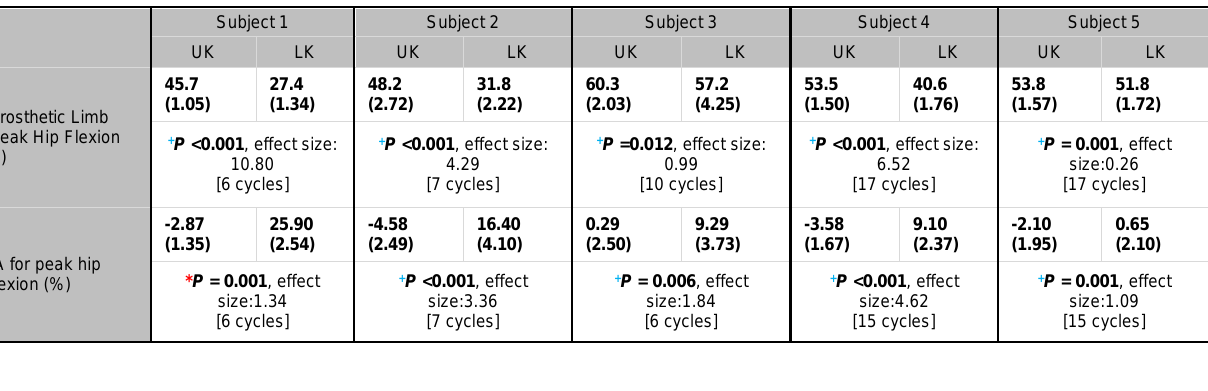
Table 2: Sagittal plane hip kinematics (mean (SD)) during swing phase for select strides in the middle 45 seconds of the three-minute self- selected running speed trial for each subject for each knee condition. Bold values denote statistically significant single-subject differences (0.05 level) between knee conditions. + Denotes a two-tailed paired t-test was conducted (normally distributed data). * Denotes the Wilcoxon signed-rank test was conducted (non-normally distributed data). UK = Unlocked knee, LK = Locked